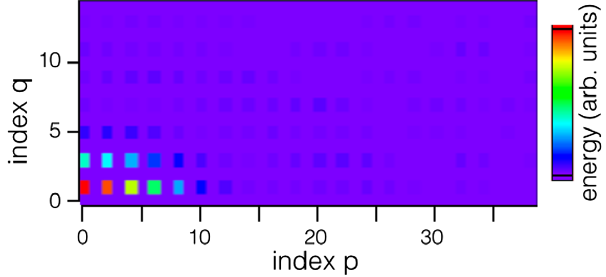
FIG. 18. Energy of the eigenmodes TEM λ ¼ 10 μ m and d